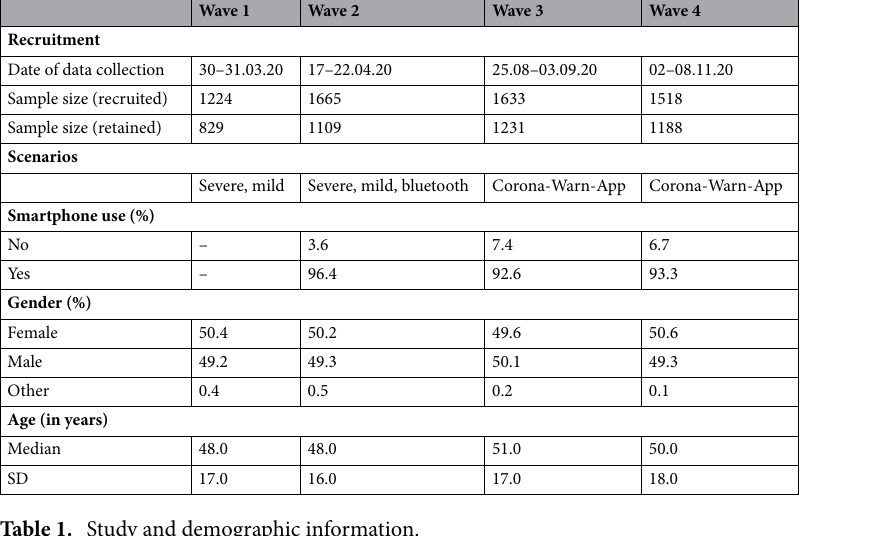
Table 1. Study and demographic